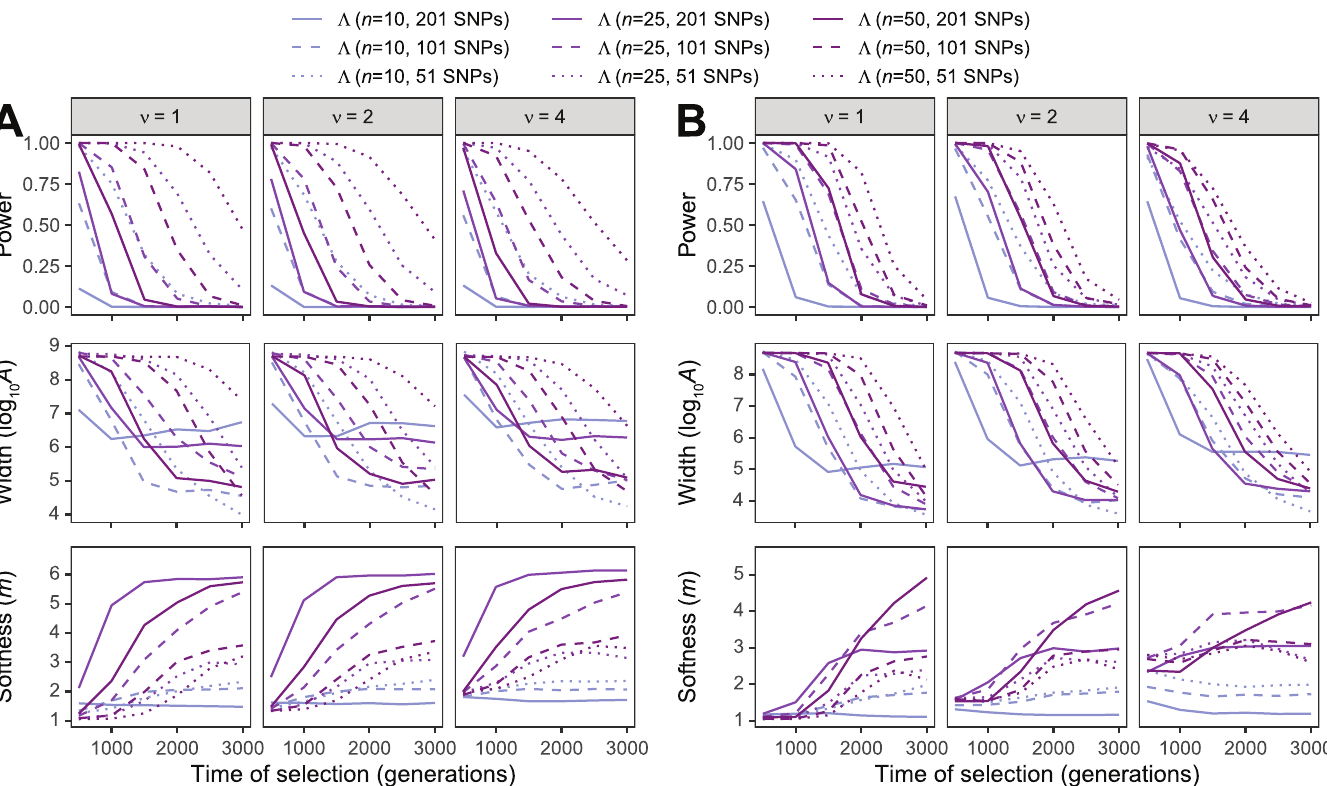
Fig 3. Performance of detecting and characterizing sweeps. Performance for applications of Λ with windows of size 51, 101, and 201 SNPs under simulations of (A) a constant-size demographic history or (B) the human central European (CEU) demographic history of [34] and sample size of n 2 {10, 25, 50} diploid individuals. Results are based on the haplotype frequency spectra for the Λ statistic truncated at K = 10 haplotypes. (Top row) Power at a 1% false positive rate as a function of selection start ^ A ) as a function of selection start time. (Bottom time. (Middle row) Estimated sweep width illustrated by mean estimated genomic size influenced by the sweep ( log 10 row) Estimated sweep softness illustrated by mean estimated number of sweeping haplotypes ( ^ m ) as a function of selection start time. Sweep scenarios consist of hard ( ν = 1) and soft ( ν 2 {2, 4}) sweeps with per-generation selection coefficient of s = 0.1 that started at t 2 {500, 1000, 1500, 2000, 2500, 3000} generations prior to sampling. Results expanded across wider range of simulation settings can be found in S20–S22 and S26–S28 Figs as well as results for application to unphased multilocus genotype data in S23–S25 and S29–S31